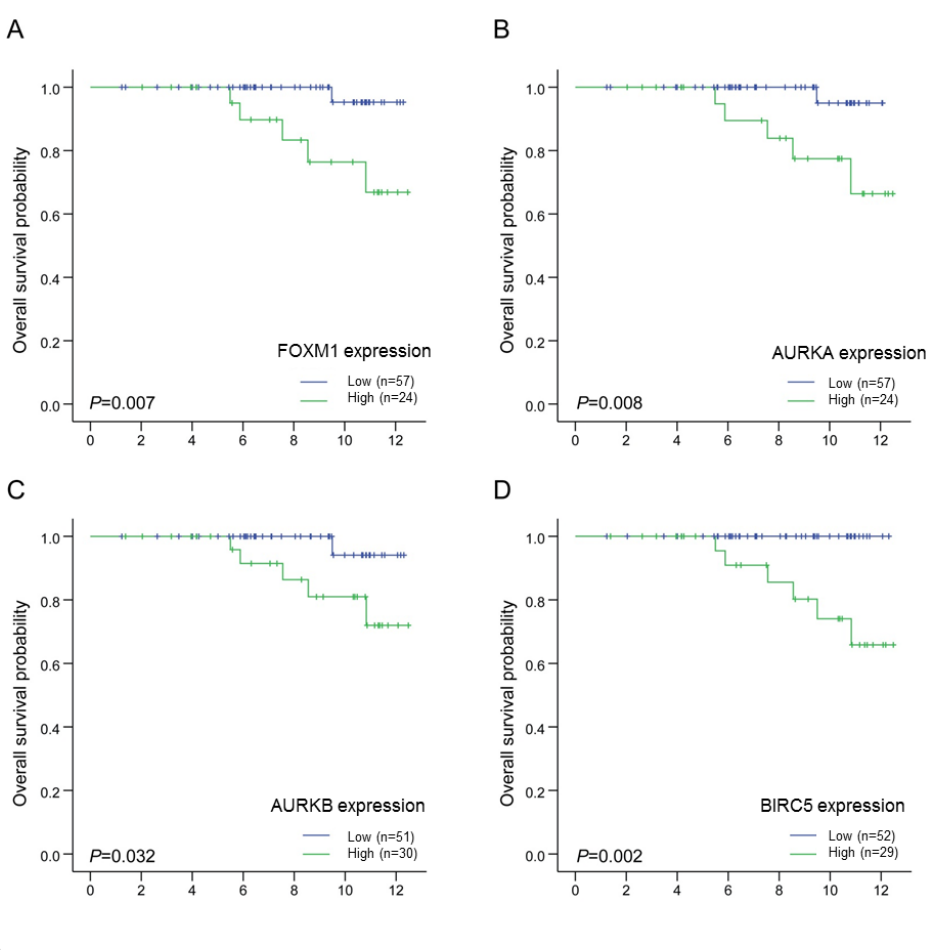
Figure 4. Kaplan-Meier plots for OS according to each genetic marker in ER-positive patients with intermediate RSs. All p -values were measured by the log-rank test. ( A ) FOXM1 , p = 0.007; ( B ) AURKA , p = 0.008; ( C ) AURKB , p = 0.032; ( D ) BIRC5 , p =